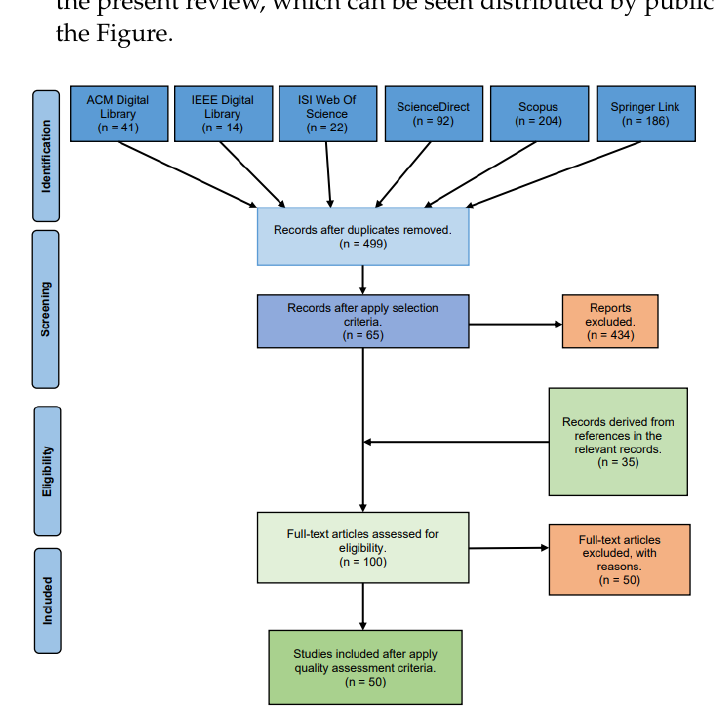
Figure 2. The Systematic Literature Review process. Adapted from [29].